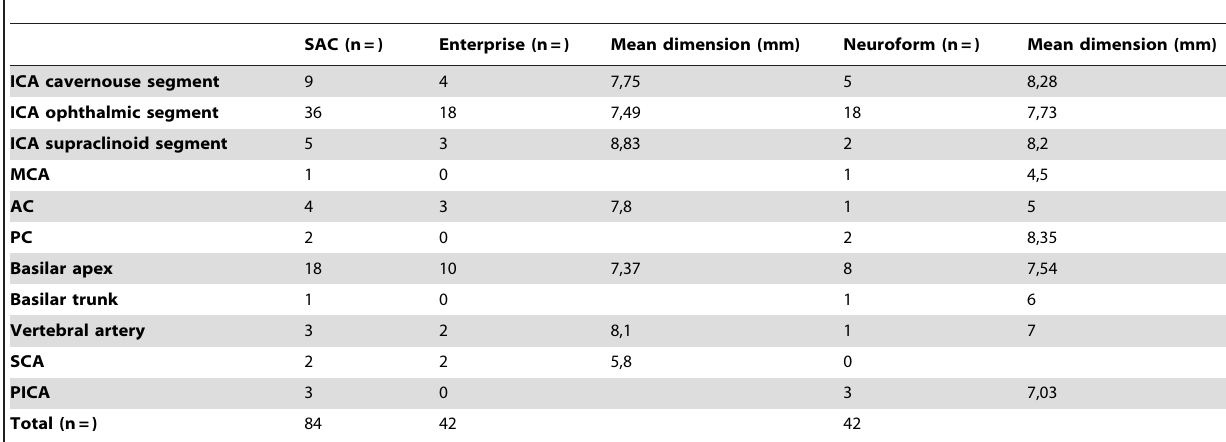
Table 2. Location and mean maximum diameter of aneurysms stented using either the Enterprise or Neuroform stent and subsequently treated by